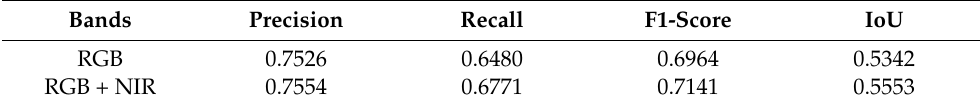
Table 4. Experimental results of road surface extraction with different band selection.